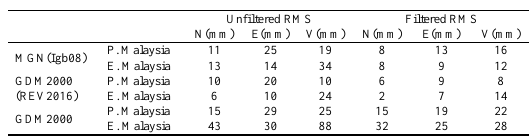
Table 6. Unfiltered and filtered RMS of MGRF2020 coordinates dif- ferences